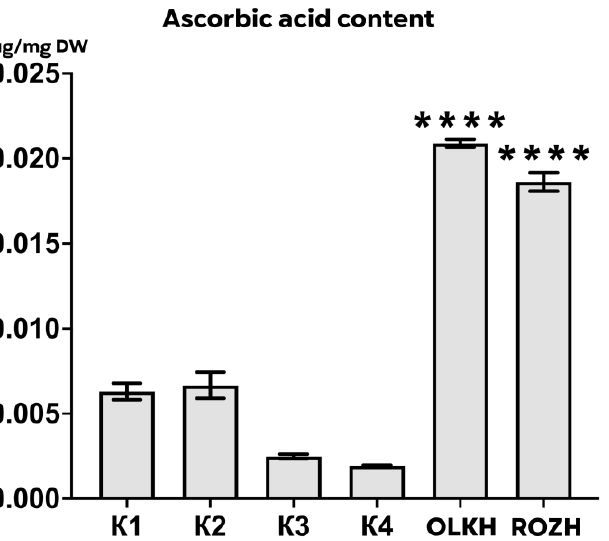
Figure 9. The ascorbic acid content in tubers of H. tuberosus grows in contaminated areas and in areas without contamination. **** corresponds to p < 0.00001 significance level.